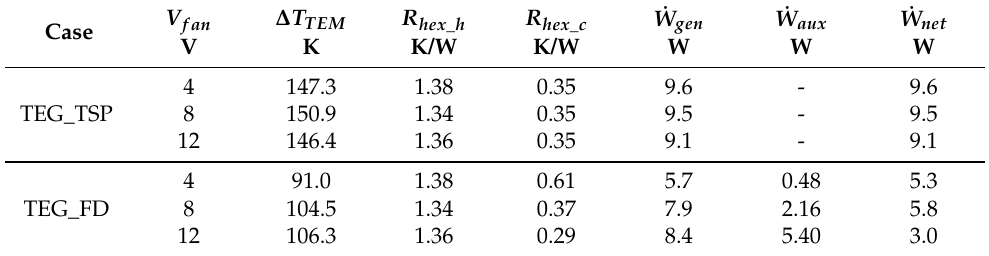
Figure 13. Influence of the auxiliary consumption on the net power output of the thermoelec- tric generators. Table 3. Experimental results of the thermoelectric generators for an inlet temperature of t in g = 405°C, a mass flow of ˙ m g = 70kg/h, and several voltages applied to the fan of the